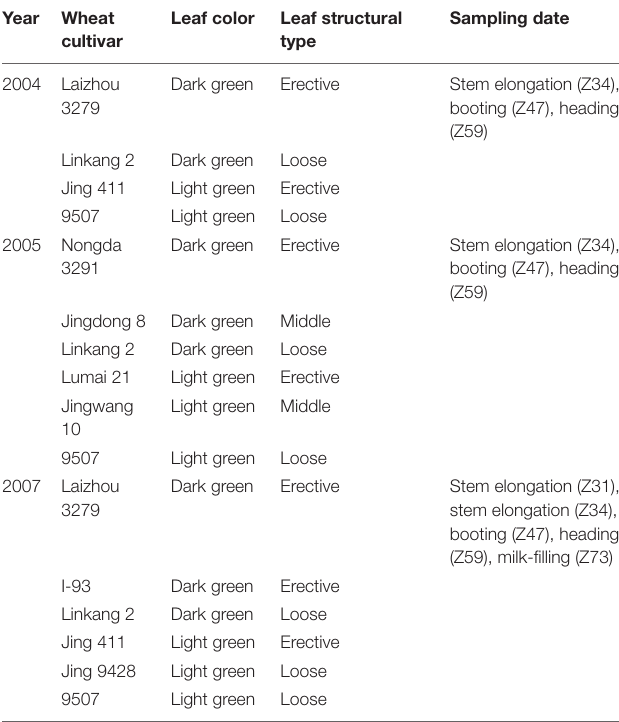
TABLE 1 | Different measurement times, wheat cultivars, leaf colors, leaf structural types, and sampling dates for the experiments. Year Wheat